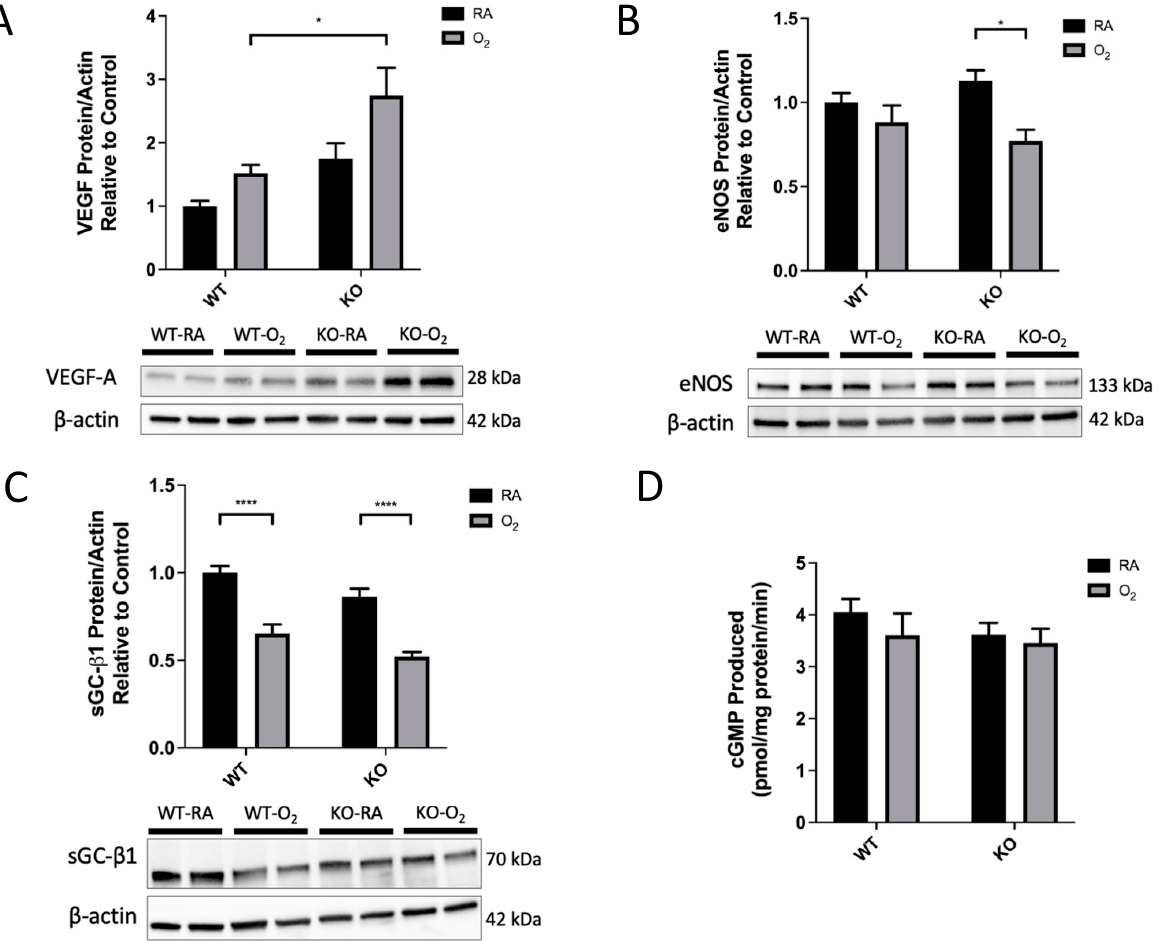
Figure 6. VEGF was increased and eNOS was decreased in combined SOD3 KO and hyperoxia. Western blot analysis was used to evaluate lung protein expression of VEGF-A, eNOS, and sGC- β 1 in WT and KO mice exposed to either RA or O 2 for 14 days. Protein expression was normalized to β -actin. Representative blots are presented. ( A ) VEGF-A expression was significantly increased by the combination of O 2 and SOD3 KO. ( B ) eNOS expression was significantly decreased by the combination of O 2 and SOD3 KO. ( C ) sGC- β 1 expression was decreased in both genotypes following O 2 exposure, but there was no genotype effect. sGC- α protein was also measured and had an identical expression pattern (data not shown). ( D ) sGC activity was measured in whole-lung lysates and was not affected by O 2 exposure or genotype. Data are presented as means (cid:3399) SEM; * p < 0.05, **** p < 0.0001 vs. WT RA; n = 4–8 per group.